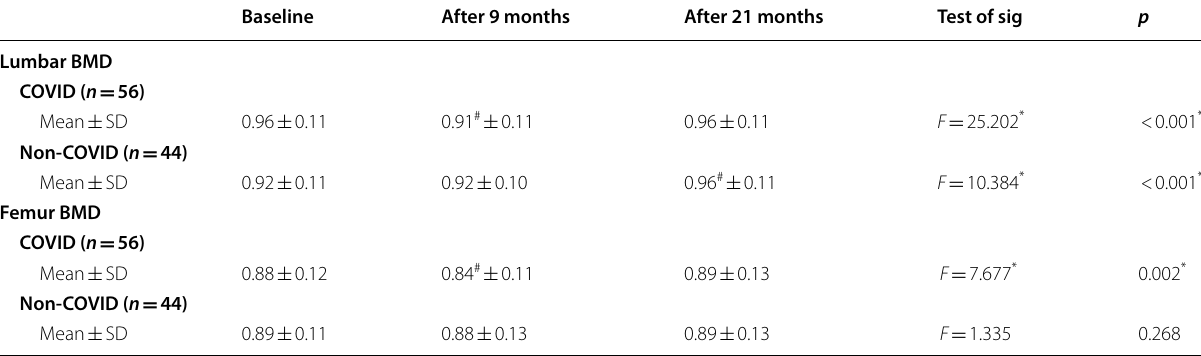
P value for comparing between the three studied periods SD standard deviation, F F test (ANOVA) with repeated measures (sig., bet. periods was done using post hoc test (adjusted Bonferroni)), BMD bone mineral density; COVID coronavirus disease # Significant with baseline * Statistically significant at p ≤